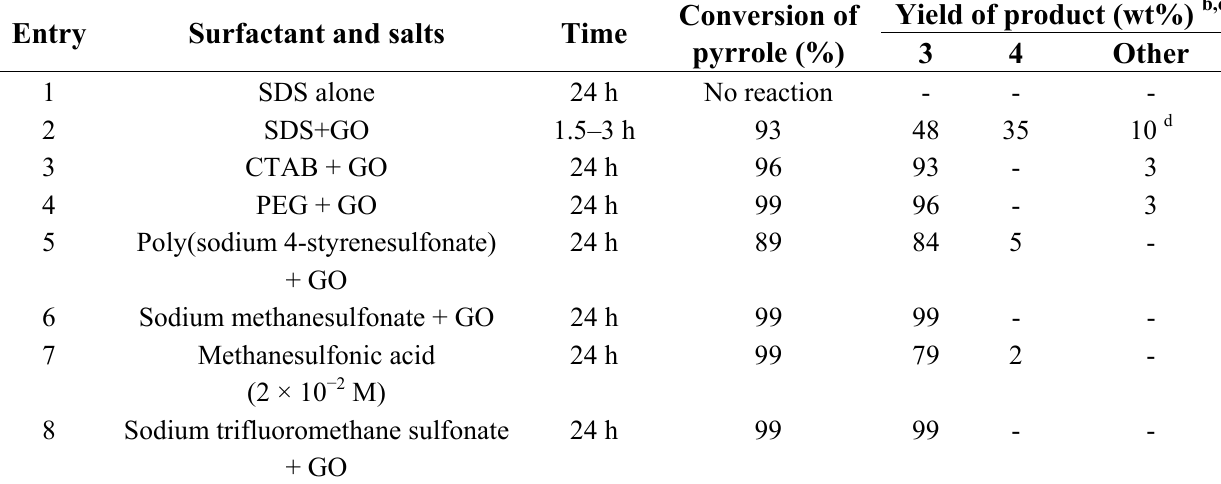
Table 3. Reaction of pyrrole and acetone in the presence of graphite oxide and surfactant and salts in aqueous solution a